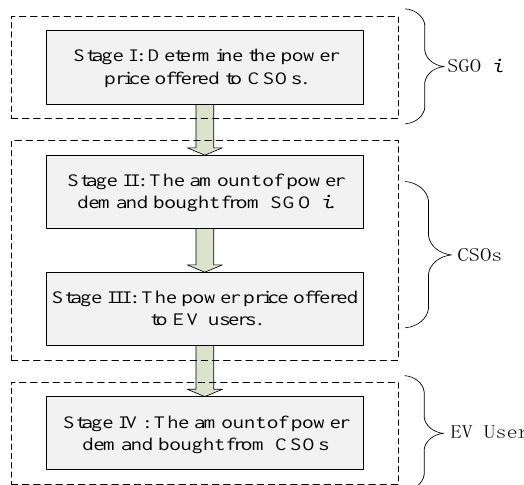
Figure 2. Four-stage Stackelberg game scheme. CSO, charging station operator; SGO, smart grid